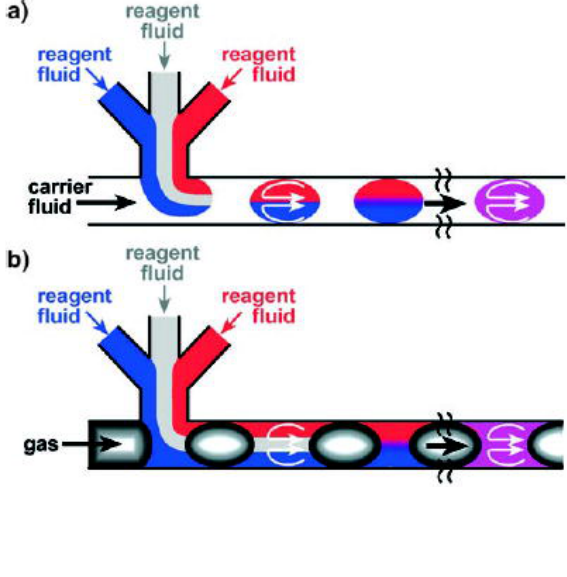
Figure 7. Segmented flows in microfluidic channels. ( a ) Discrete liquid plugs are encapsulated by an immiscible continuous phase (carrier fluid) and, due to the surface properties of the micro-channel walls, they are preferentially wet by the continuous phase; ( b ) Aqueous slugs are separated by another immiscible phase and reactions occur within the continuous phase